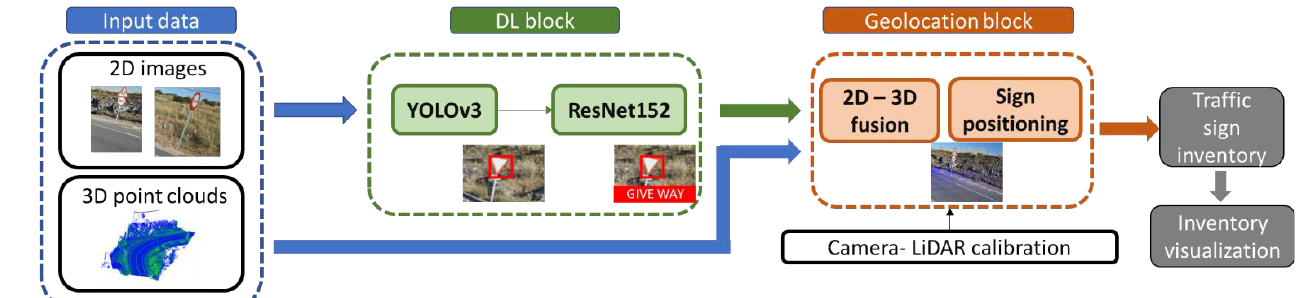
Figure 2. High-level workflow of the method developed for traffic sign inventory.